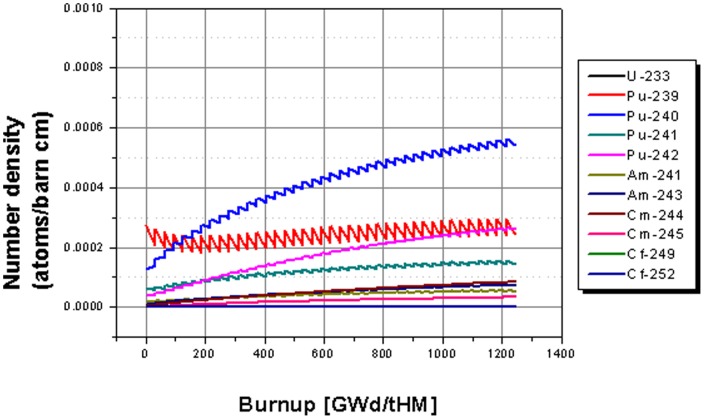
Evolution of the isotope inventory for the case of a fertile free core.